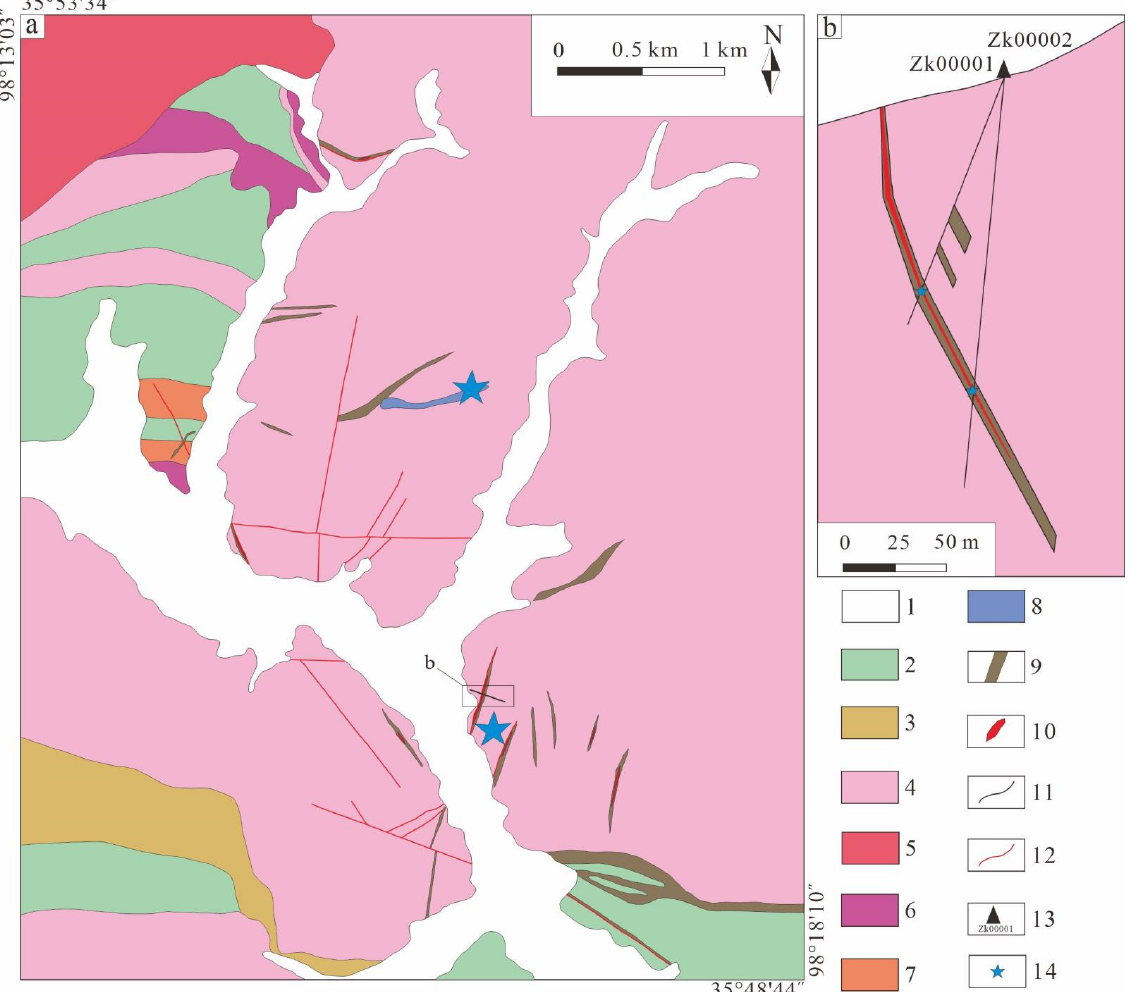
Figure 2. Geological map of Asiha gold deposit ( a ), Cross section of Line 0 in Figure 2a ( b ) (modified from [19]). 1. Quaternary; 2. Proterozoic migmatite; 3. Proterozoic gneiss; 4. Quartz diorite; 5. Monzogranite; 6. Plagiogranite; 7. Diorite; 8. Granite porphyry; 9. Fractured alteration zone; 10. Gold orebodies; 11. Geological boundary; 12. Fault; 13. Drillcore; 14. Sample location.